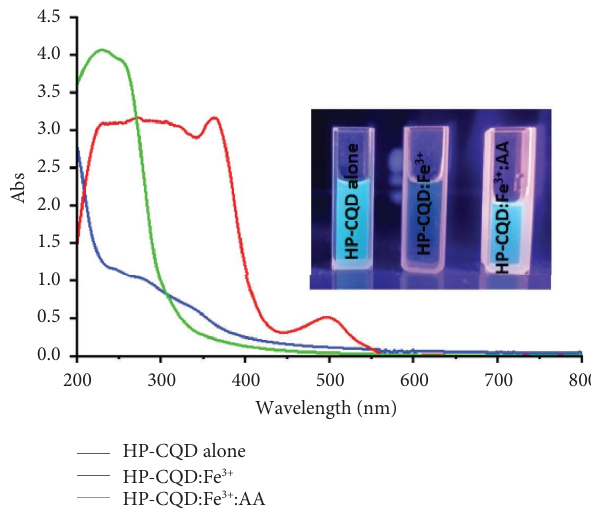
Figure 7: UV-vis spectra and inset image describe the mechanism of on-of-on of HP-CQD for sensing of Fe 3+ and L-ascorbic